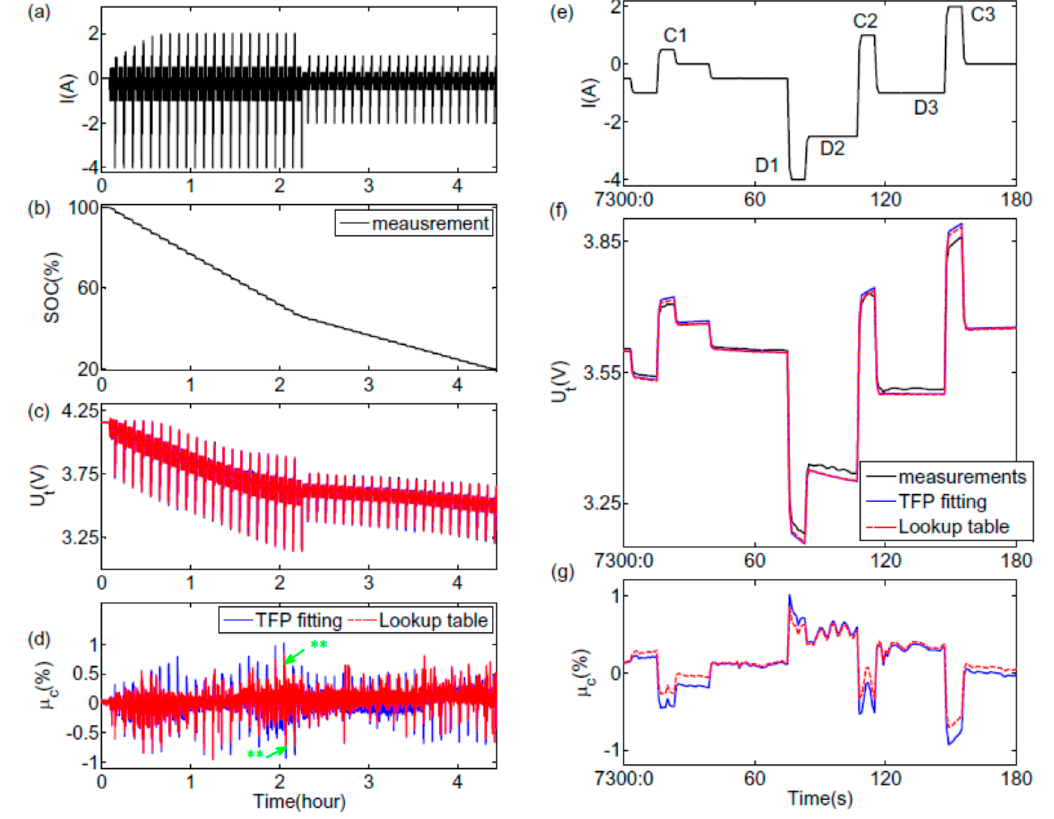
Figure 7. Battery model validation profiles: ( a ) current, I ; ( b ) SOC; ( c ) voltage, u t ; ( d ) voltage relative errors, µ c ; ( e ) enlarged current, I ; ( f ) enlarged voltage, u t ; ( g ) enlarged voltage relative errors, µ c .